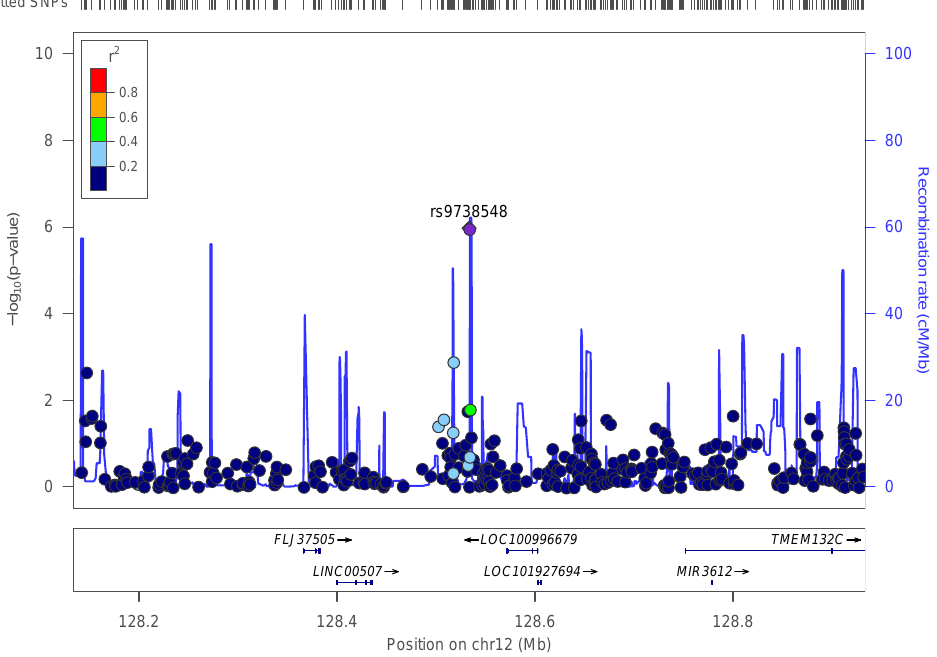
Figure 1. Regional plot for the lead SNP rs9738548, located on chromosome 12 (intergenic), in the GWAS for adiponectin concentrations in the whole population. p -values obtained in the general linear regression model adjusted for sex, age, diabetes and BMI.